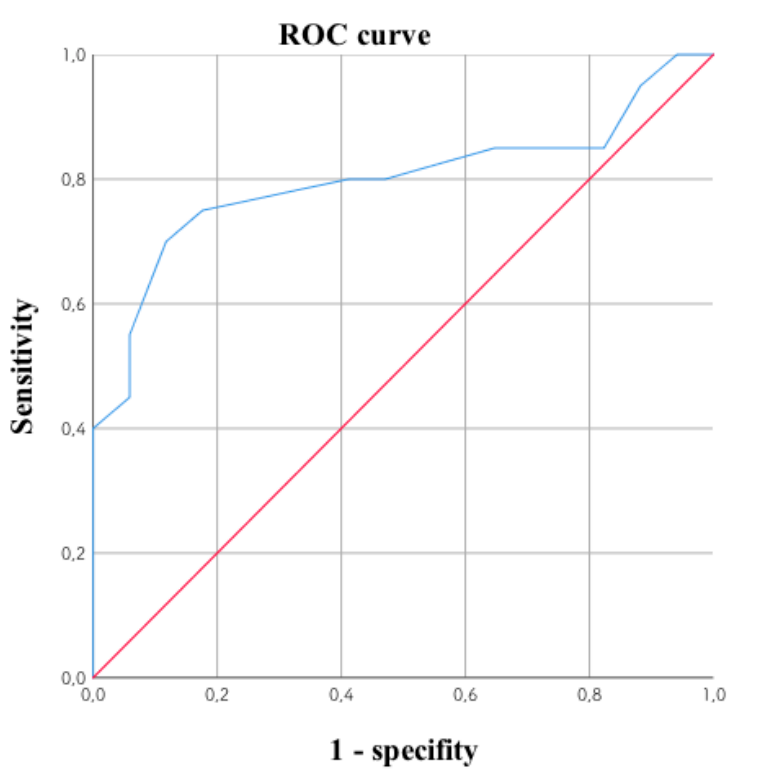
Figure 4. ROC curve for BDI_12. The TSH level was tested once, and the BDI was measured after 12 weeks. The ROC curve is related to the BDI_12 prediction based on the TSH level.